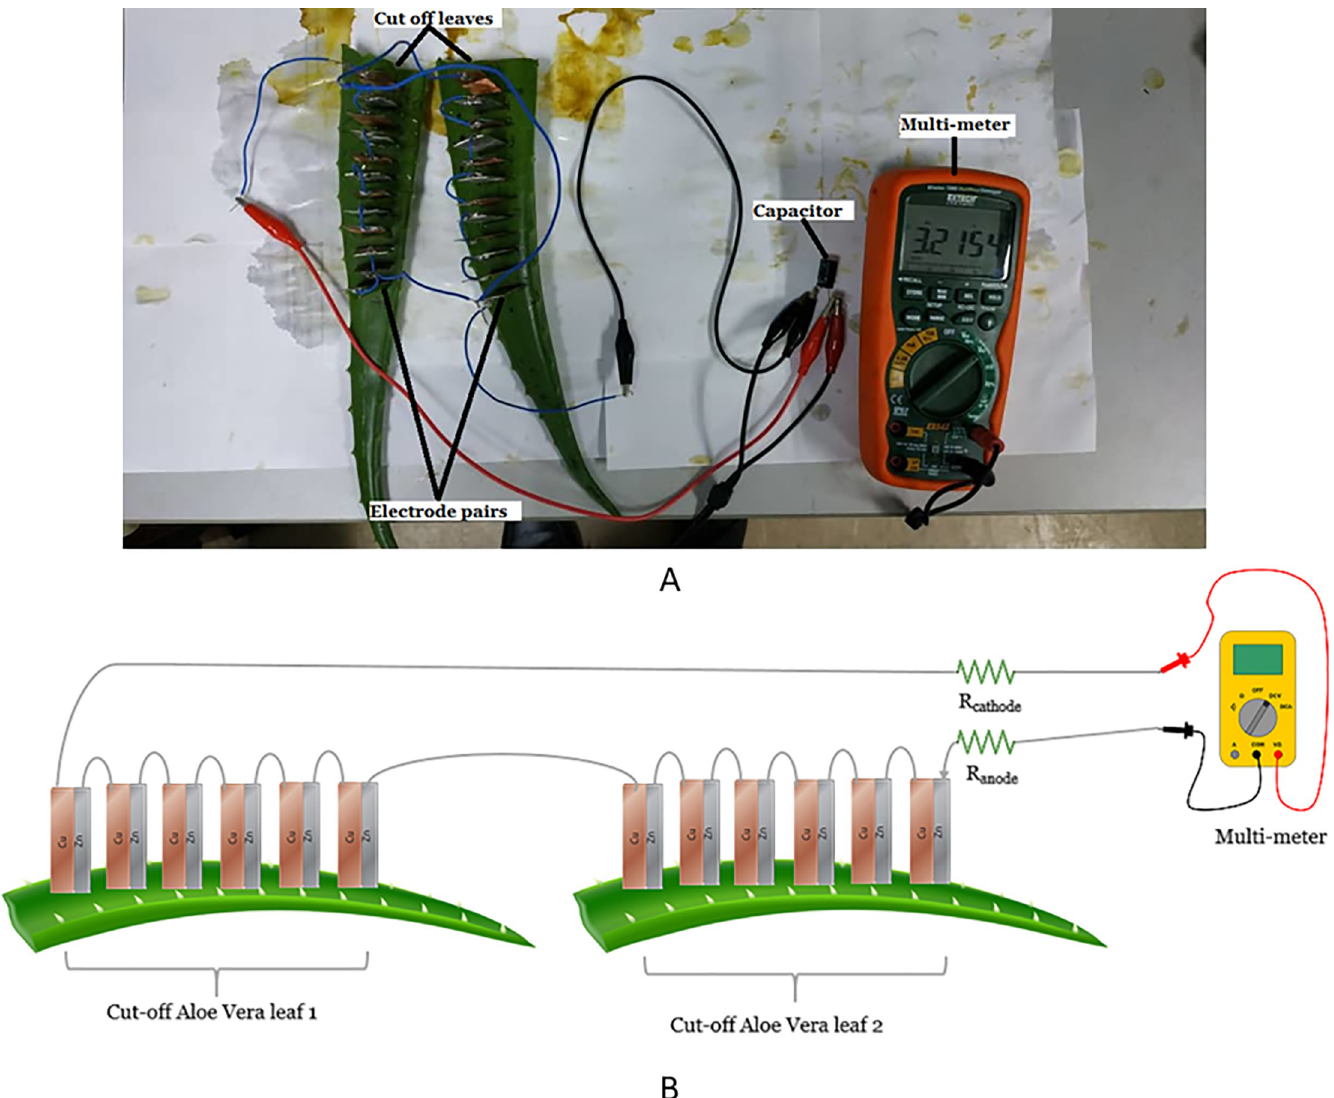
Fig 15. Experiment setup for charging a capacitor with cut off leaves disconnected from the Aloe Vera. Example of setup arrangement (A) and simple schematic of the setup (B).